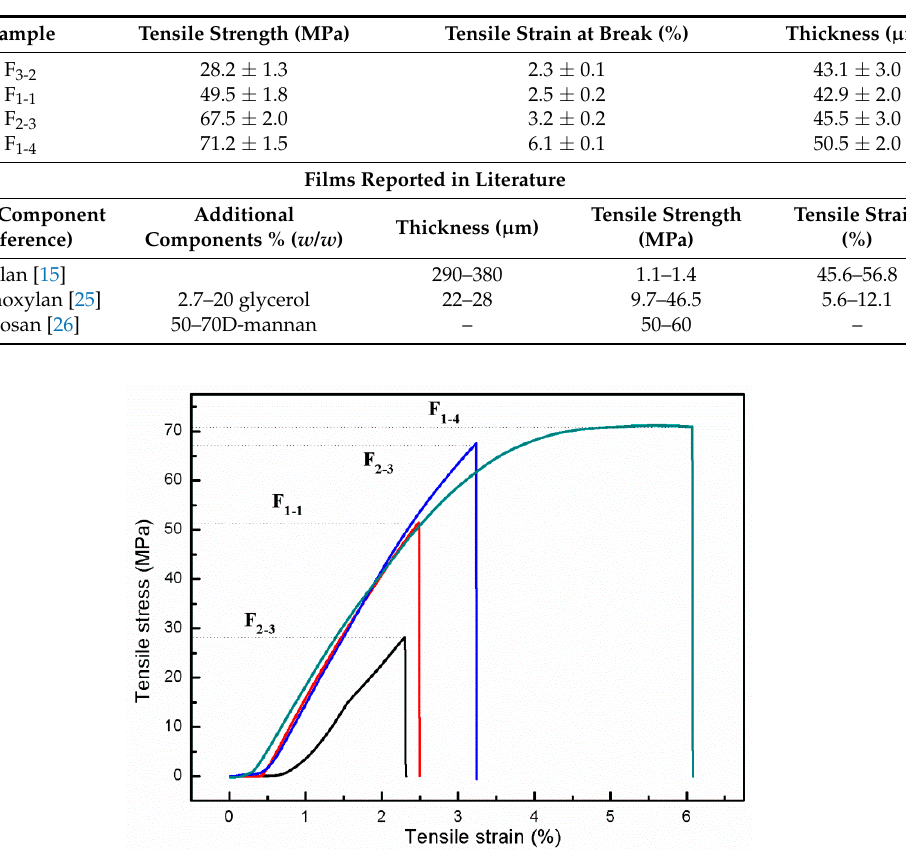
Table 2. Tensile testing results of the composite films.